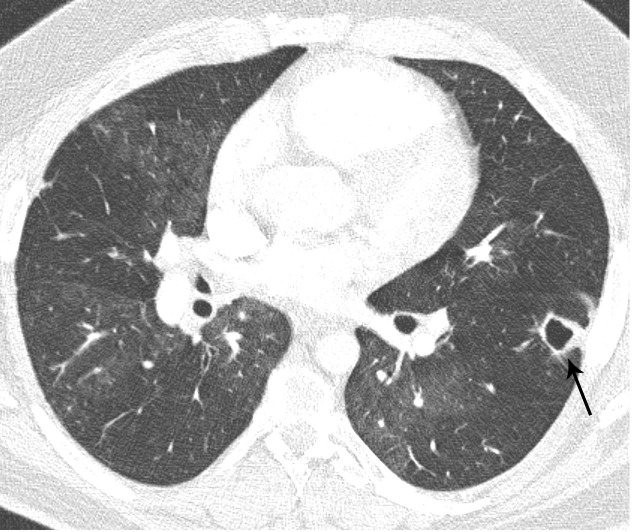
Parenchymal densities in patients with CTEPH.Axial CT image shows peripheral cavitary mass (arrow) combined with mosaic perfusion pattern 1.